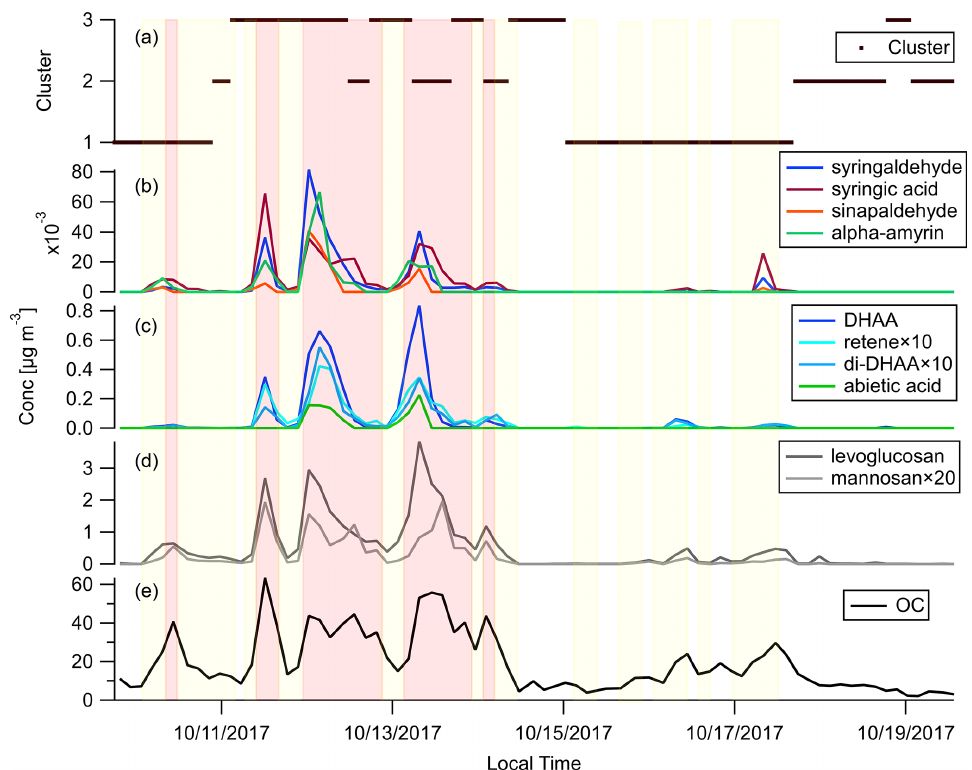
Figure 5. Time series of (a) backward trajectory clusters, (b) hardwood primary BBOA markers, (c) softwood primary BBOA markers, (d) general primary BBOA markers, and (e) OC. Light red shading shows the plume periods, and light yellow shading shows the BB influence periods as described in Sect.